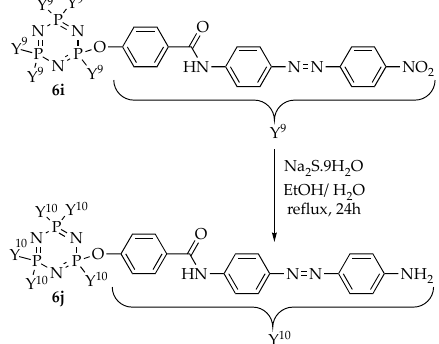
Scheme 3. Reduction of compound 6i to 6j [32,34].